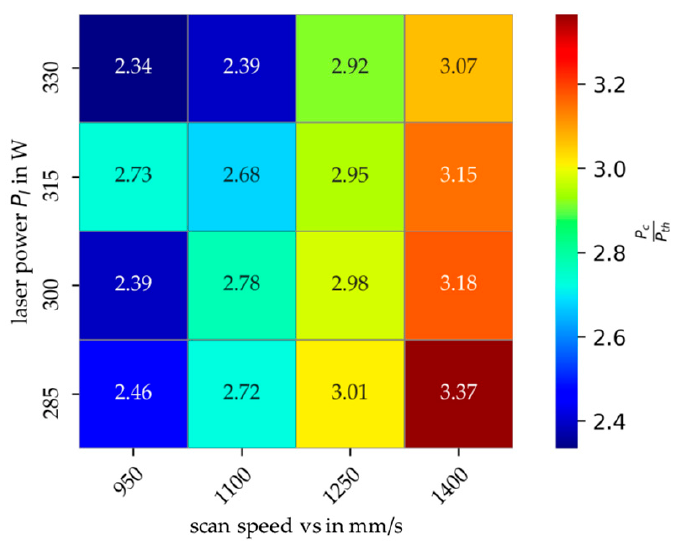
Figure 6. Shape and contour accuracy determined from the ratio of the actual sample perimeter and its theoretical perimeter P C /P th . Low values stand for a smooth sample surface.